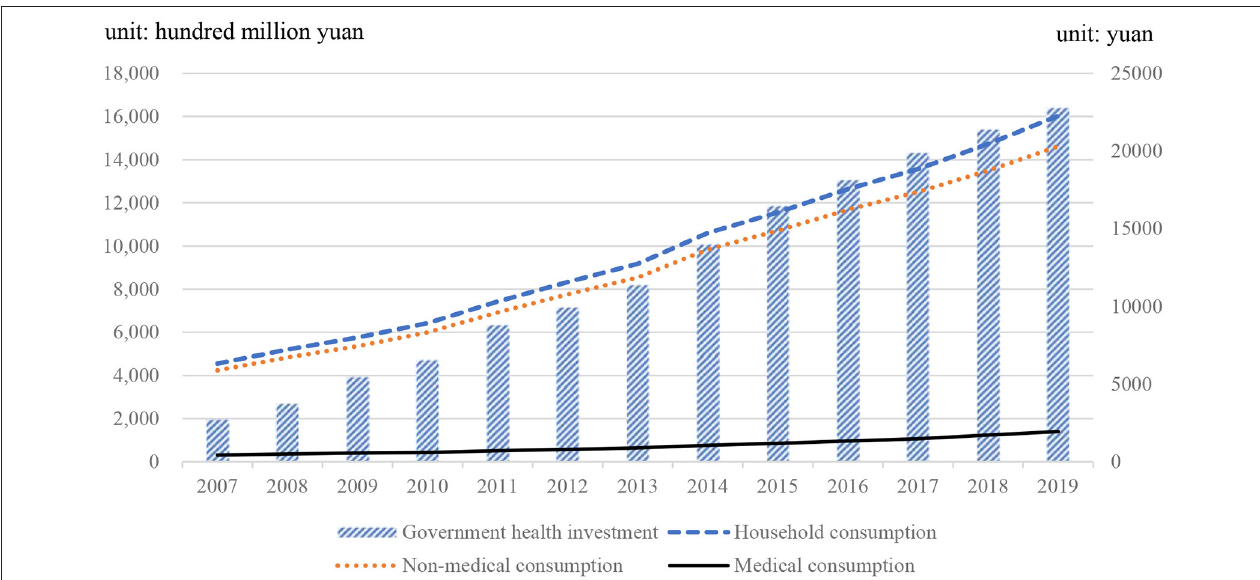
FIGURE 1 | Changes in government public health investment and household consumption. Data source: China Statistical